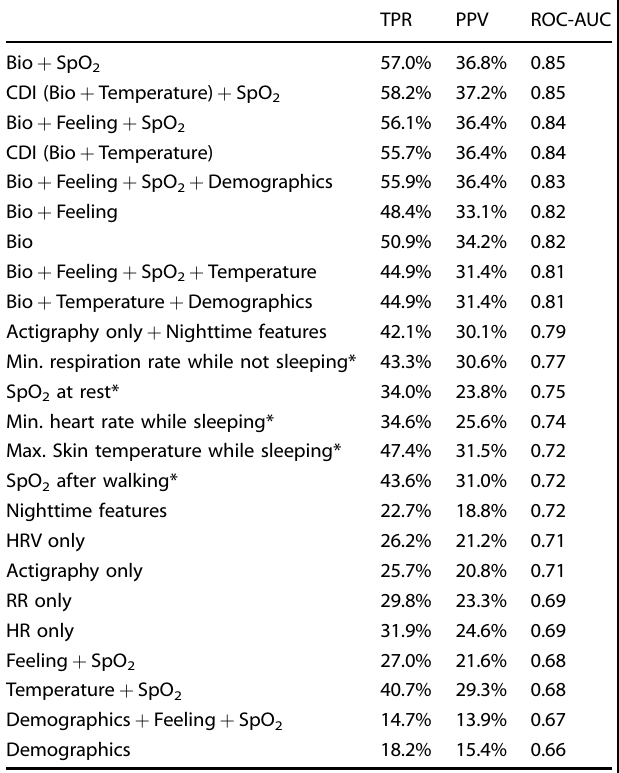
Table 2. Performance of univariate features and multivariate